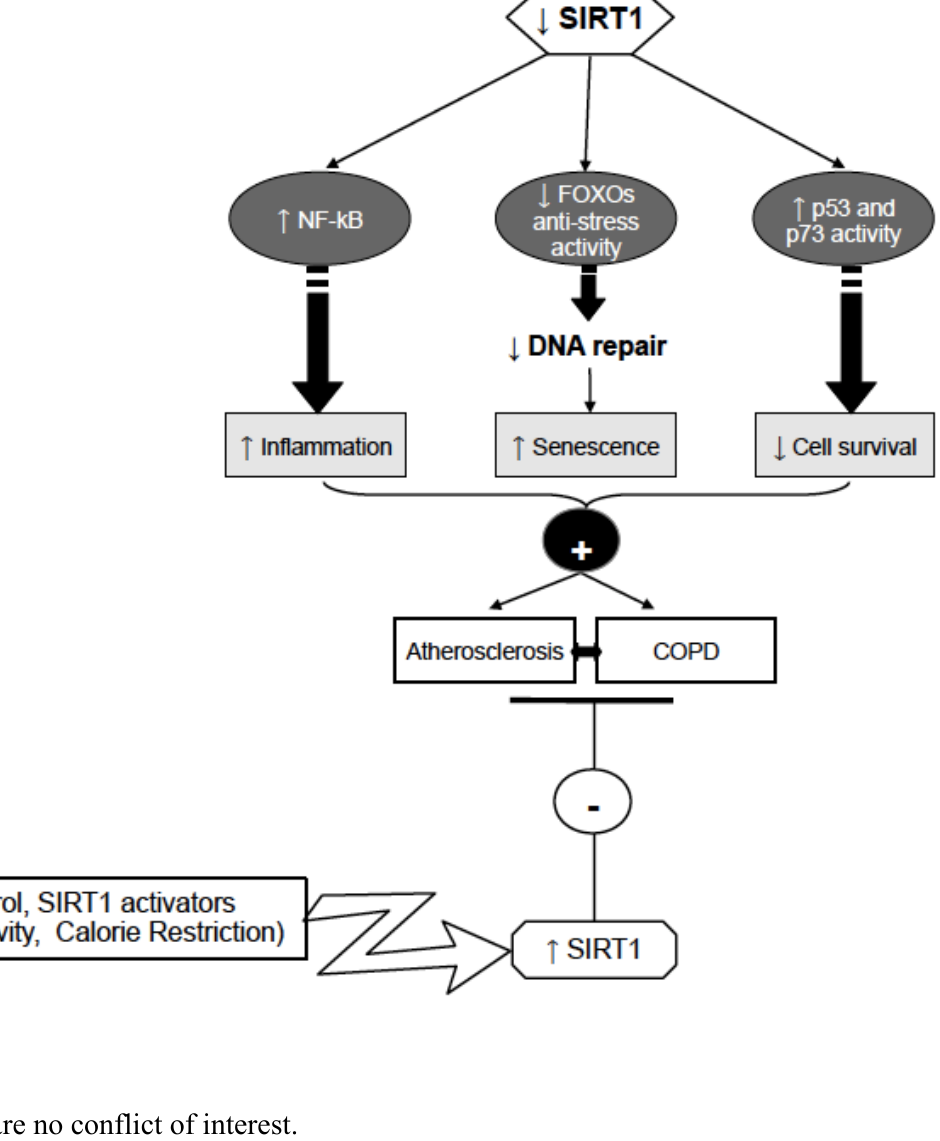
Figure 1. Possible mechanisms involving SIRT1 in Atherosclerosis, and COPD control. Sirt1 activation by activators such as physical activity could prevent atherosclerosis and COPD development through reduction of inflammation (by decreasing NF- κ B), and increasing DNA repair (by FOXOs activation) and cell survival (by p53 and p73 activity